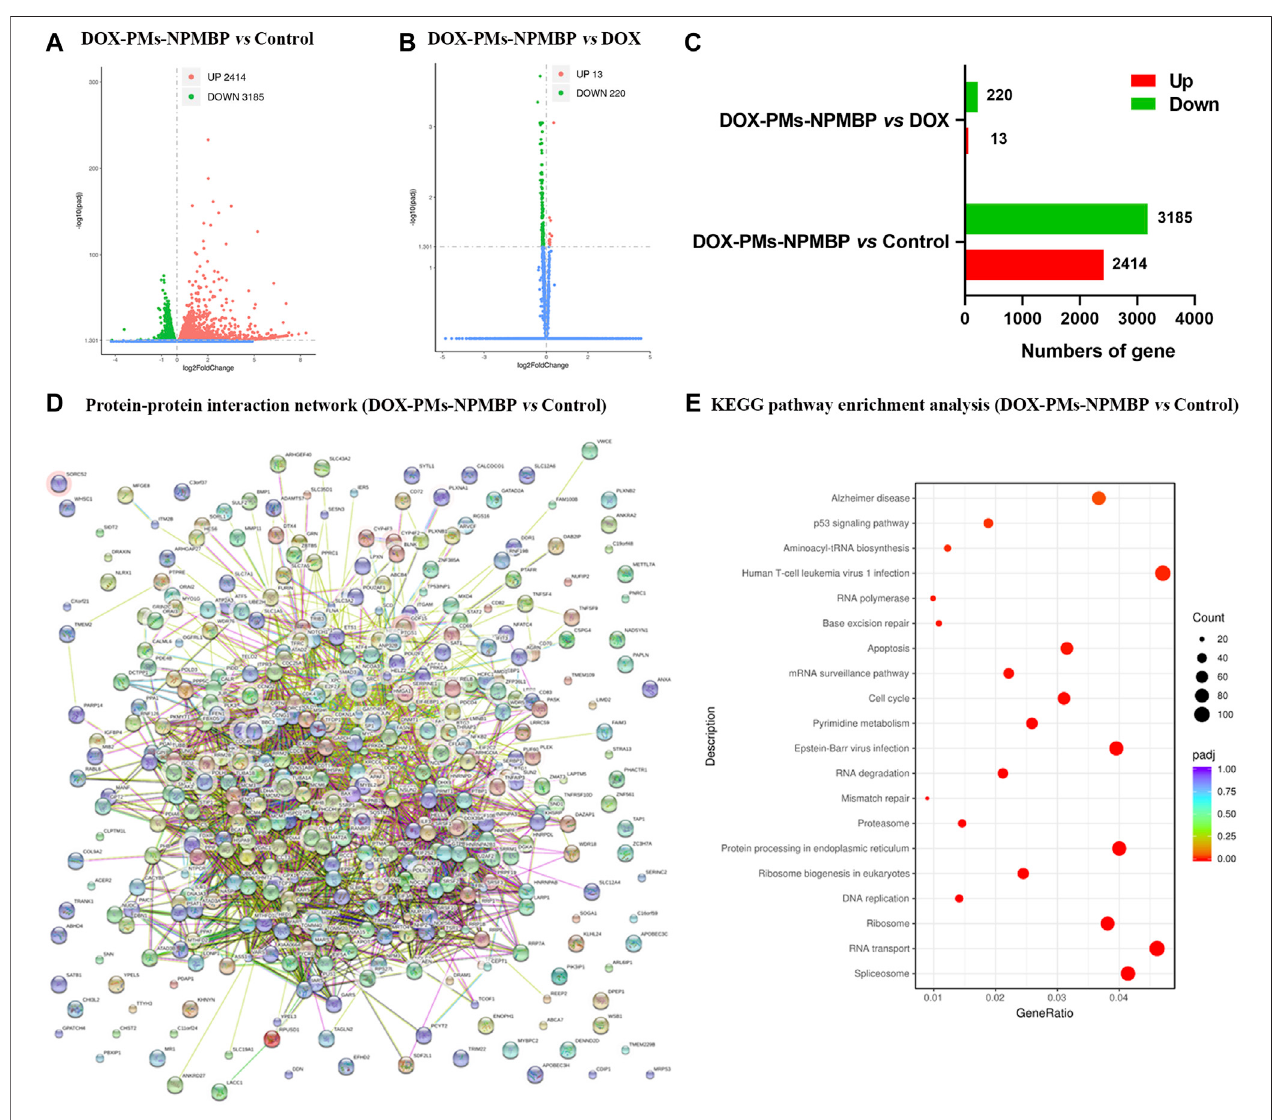
FIGURE 4 | Bioinformation analysis based on RNA-seq data. (A – C) Volcano plots of differentially expressed genes (DEGs) in Nalm6/DOX cells administered DOX, DOX-PMs-NPMBP, and vehicle control. (D) DOX-PMs-NPMBP-associated protein interaction network. Each circle means a protein/gene (node). (E) DOX-PMs- NPMBP-associated Kyoto Encyclopedia of Genes and Genomes (KEGG) pathway enrichment